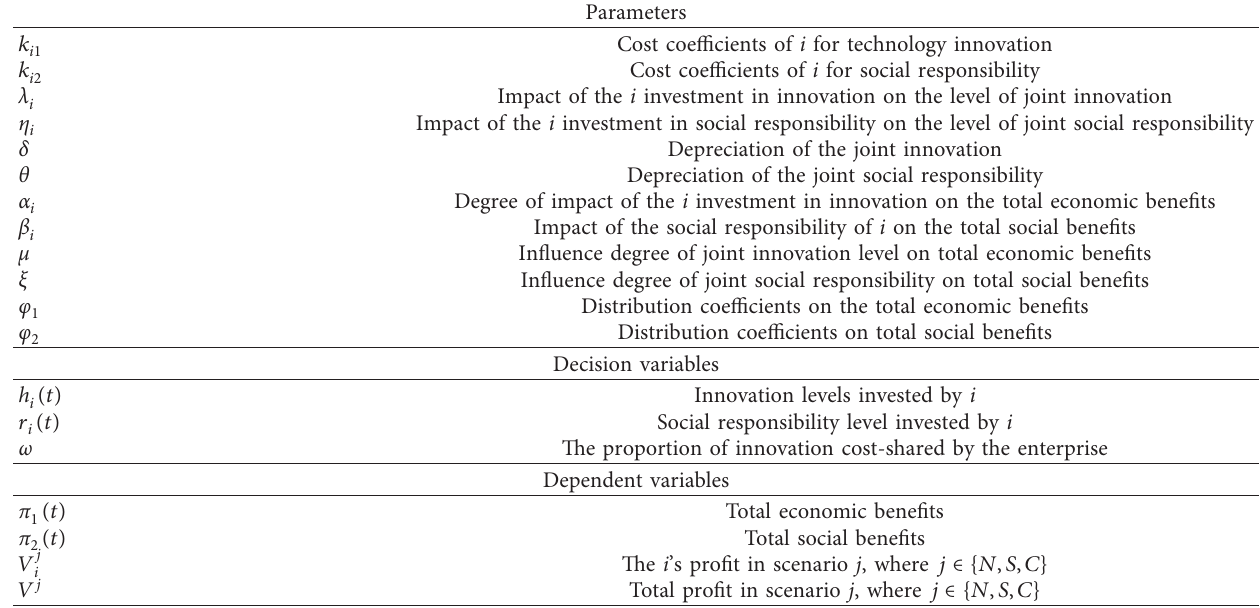
Table 1: Summary of basic